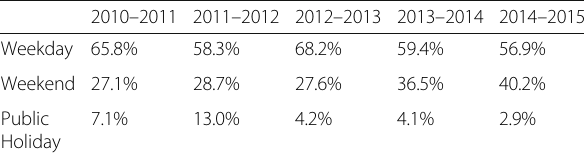
Table 3 Distribution of out-of-hours cases performed